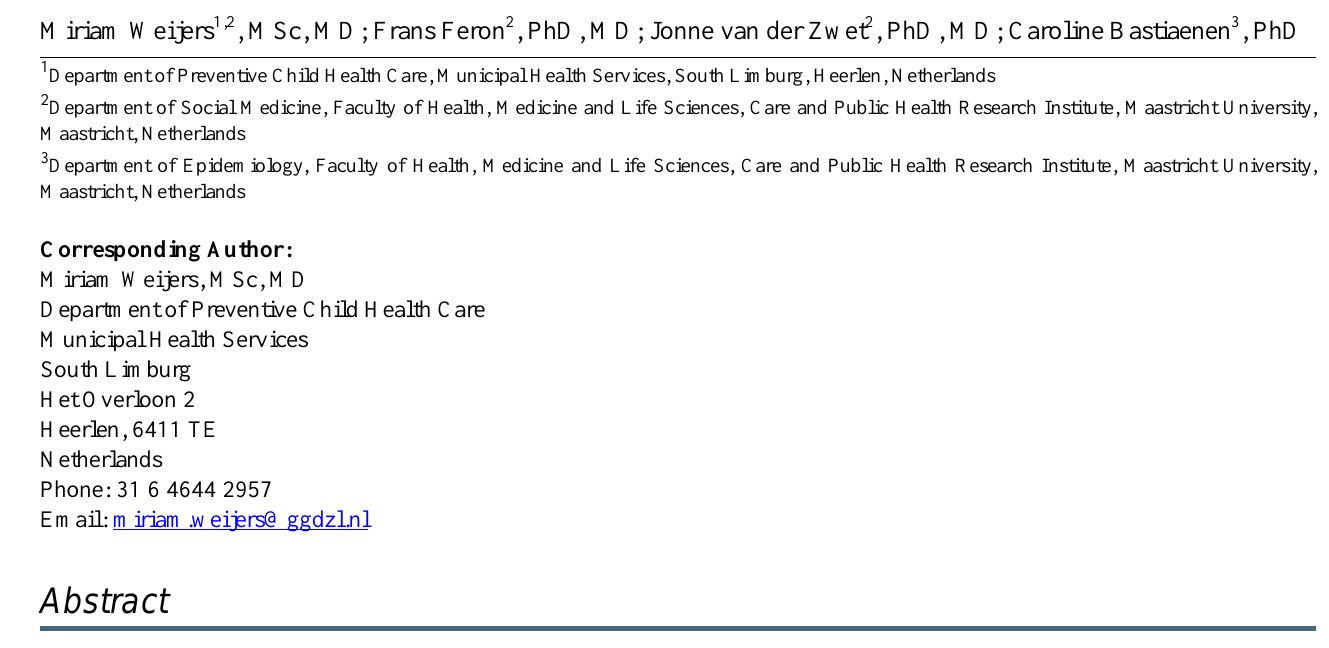
child health services; prevention; control; personalized health care; international classification of functioning; disability; health; patient; access to records; personalized; child;